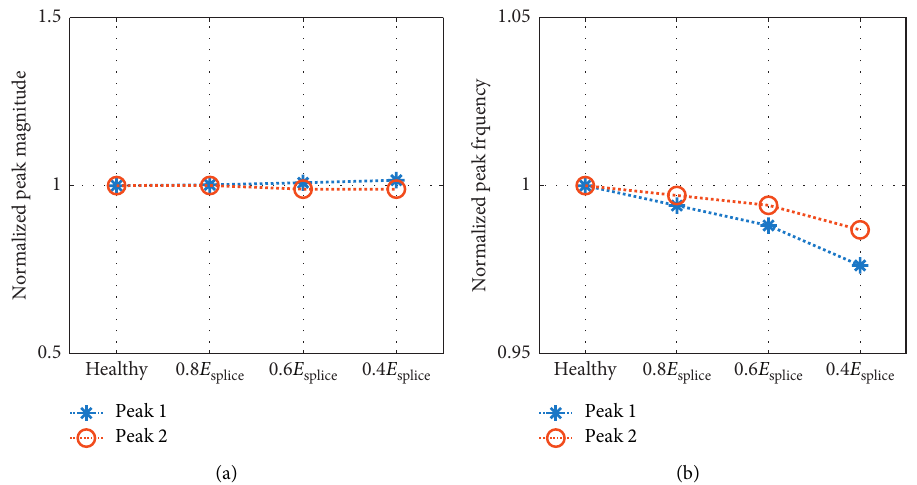
Figure 31: Shifts in peak magnitude and peak frequency due to structural damage. (a) Peak magnitude. (b) Peak